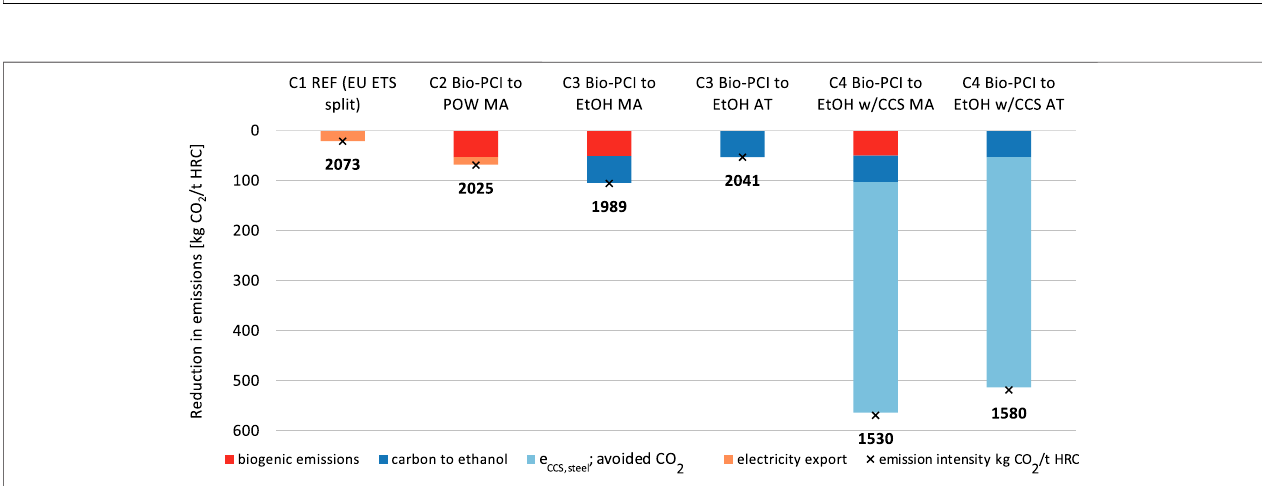
FIGURE 9 | Emissions compared to the reference mill and the resulting emission intensity ( × ) of the steel product, depending on the steel mill con fi guration and allocation scheme, that is, allocation by carbon mass balance (MA) and free attribution (AT), which maximizes the amount to biogenic carbon assigned to the ethanol production. The allocation of CO 2 avoided (CCS) is 93:7 (steel:ethanol) based on mass allocation. The grid intensity is 295.6 gCO 2 /kWh (EU average).